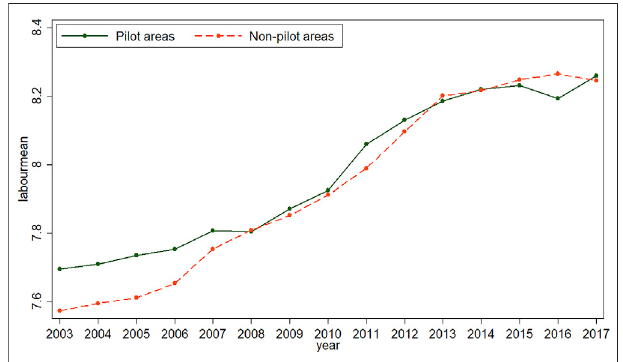
FIGURE 1 | Changes in the average enterprise employment in pilot and non-pilot regions.